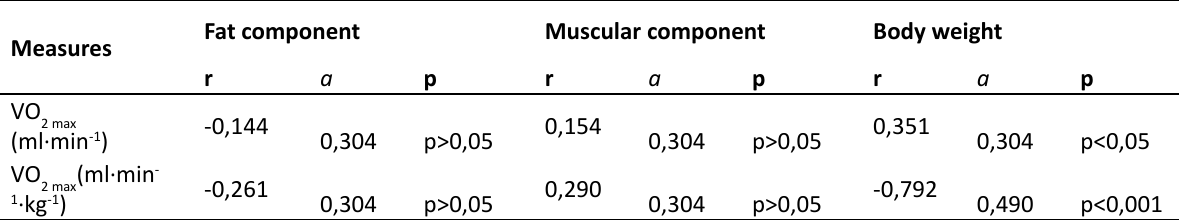
Table 5. Interrelation of the maximum consumption of oxygen with body weight and body component structure of women (endomorphic and mesomorphic somatotype)